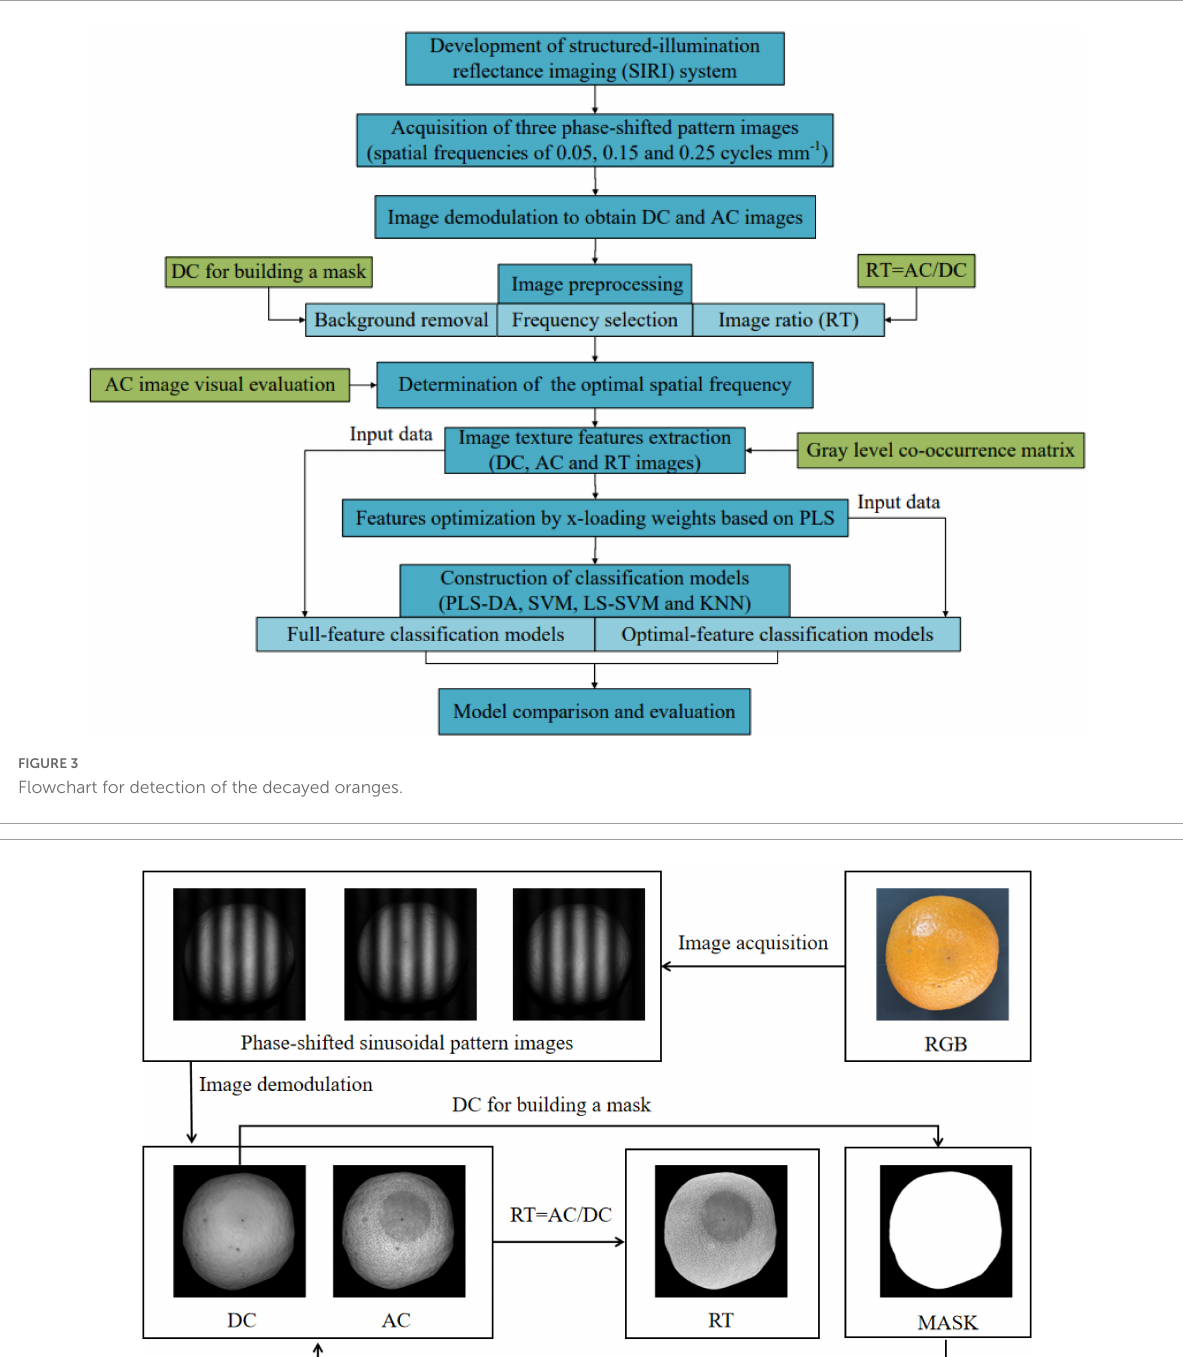
FIGURE4 The structured light image processing including image demodulation, background removal, and image ratio.